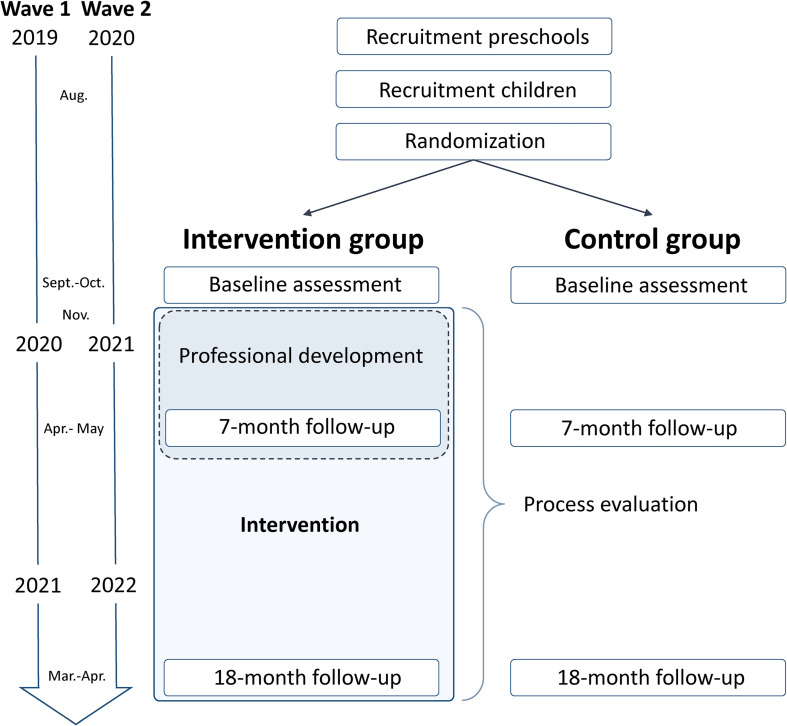
Flow chart of the study.